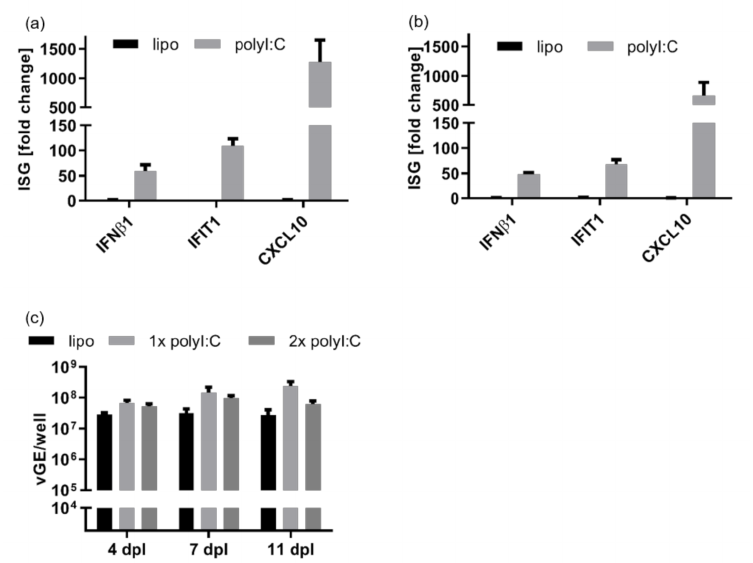
Figure A4. ISGs are specifically upregulated by poly I:C stimulation. Both WT ( a ) and MDA5-/- ( b ) HepG2-NTCP cells were stimulated with poly I:C at 100 ng/mL for 6 h. Extracted RNA was subjected to qRT-PCR and IFN β and ISG upregulation is given as fold induction relative to non- stimulated cells. Graph depicts a single experiment with biological triplicates. ( c ) WT HepG2-NTCP cells seeded in a 6-well plate were stimulated with polyI:C at 100 ng/mL at 6 h pre-infection (1 x polyI:C) and re-stimulated with polyI:C at 100 ng/mL at day 4 post infection. Extracted RNA was subjected to qRT-PCR and absolute numbers of vGE/well are depicted. Bars represent a single experiment with biological